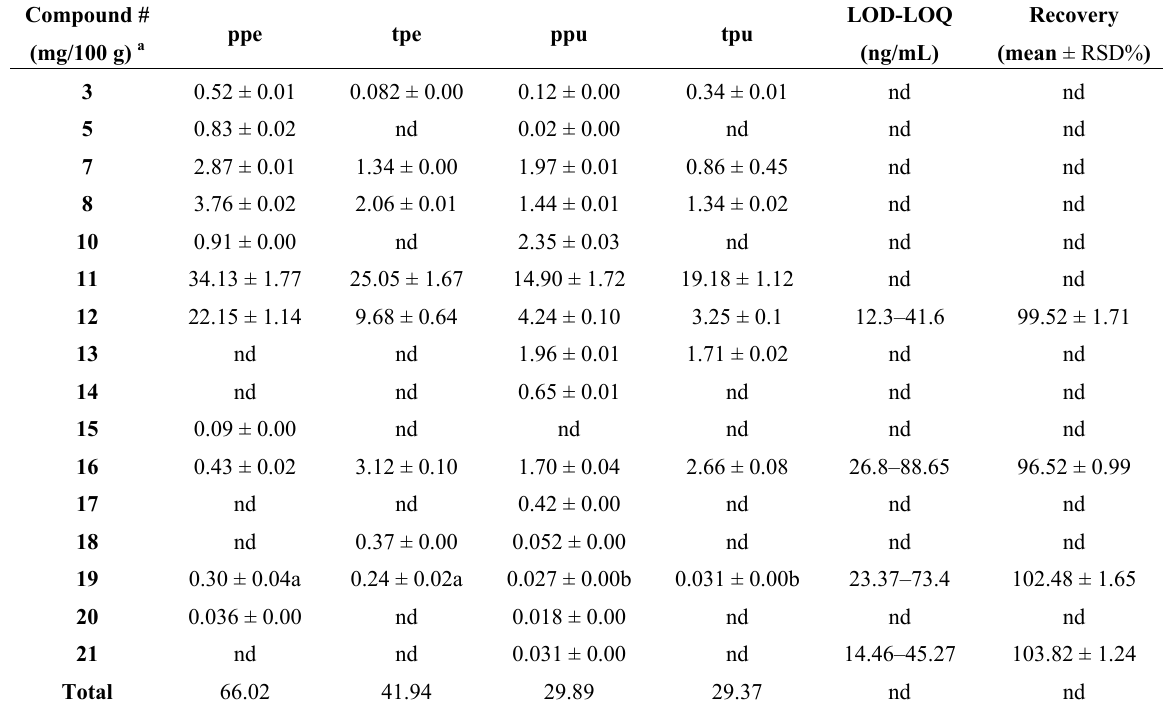
Table 2. Content of major phenolic compounds in peel and pulp of Pica and Tommy Atkins mango